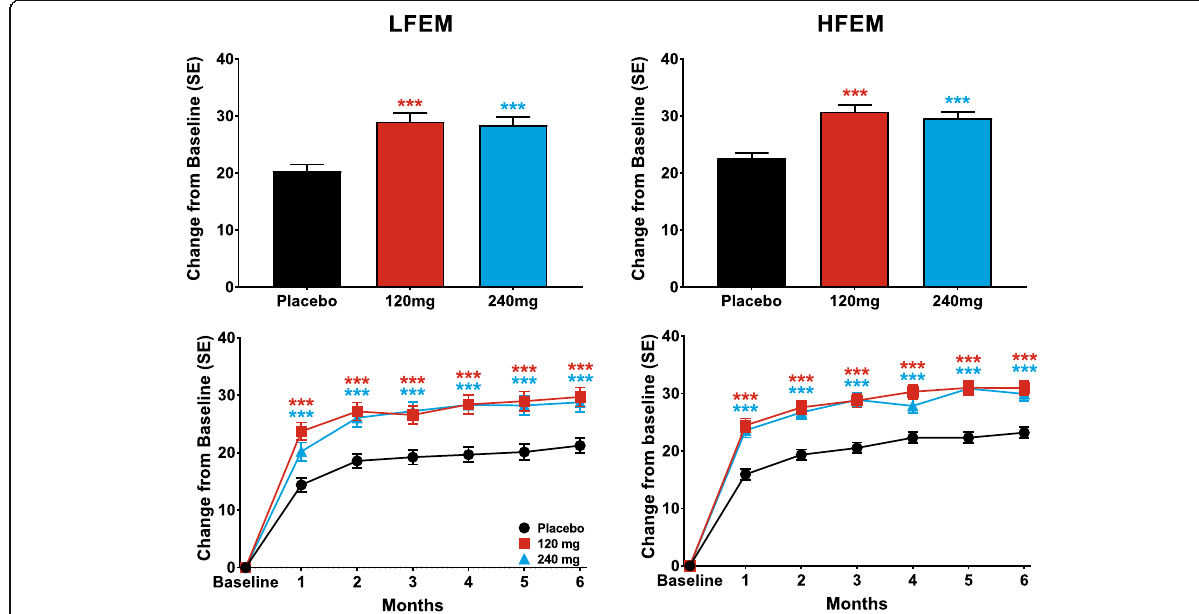
Fig. 6 The overall least-squares (LS) mean change in the Migraine-Specific Quality of Life Questionnaire role function-restrictive domain (MSQ- RFR) is shown for patients with LFEM and HFEM receiving placebo, 120-mg, or 240-mg of galcanezumab in the upper row. The monthly LS mean changes in MSQ-RFR for patients receiving these treatments is shown in the bottom row for patients with LFEM and with HFEM. ***p ≤ .001, **p ≤ .01, *p ≤ .05 vs placebo